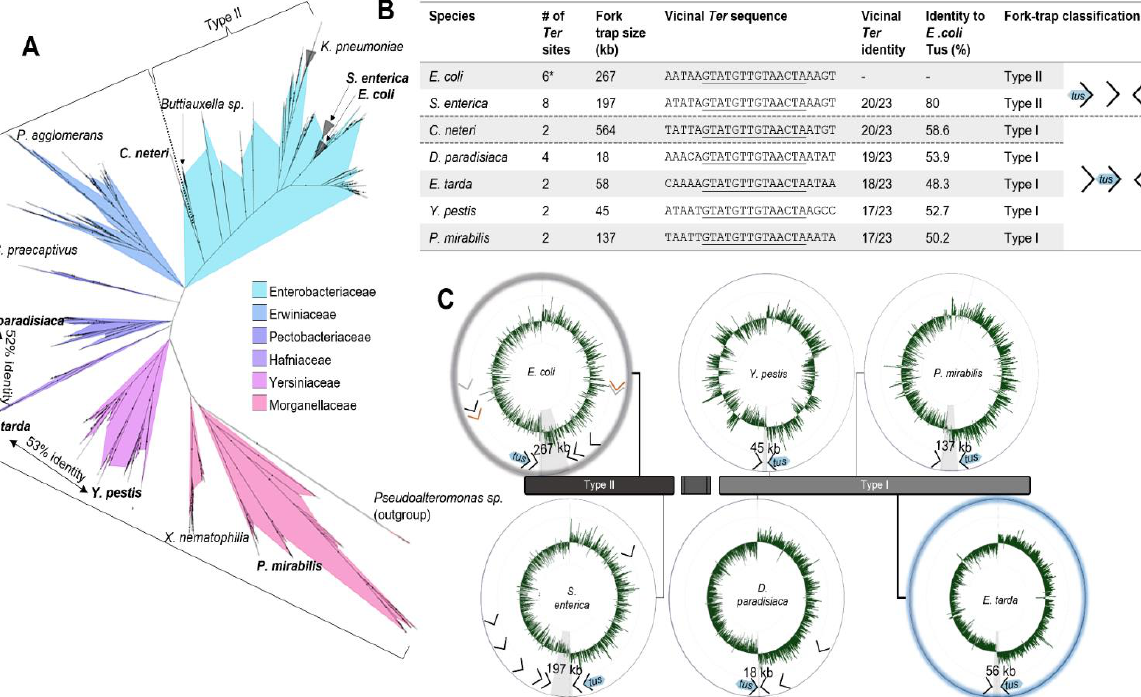
Figure 3. Phylogenetic analysis of Tus orthologs and fork trap architecture in Enterobacterales. ( A ) Unrooted phylogenetic relationship of ~2500 Tus protein sequences using InterPro entries (IPR008865) highlighting the transition of a simple type I to complex type II fork trap architecture, which occurs at Cedecea . ( B ) Chromosomal fork trap characteristics and classification for selected species (see Figure S7 and Table S1 for their graphical representations and the complete table of species). Fork trap size (kb) corresponds to the distance between the two innermost Ter sites of opposite polarity. Underlined bases represent a continuous identical sequence shared between all Ter sequences vicinal to tus starting at the GC(6) base- pair. ( C ) The different types of replication fork trap architecture in Enterobacterales.